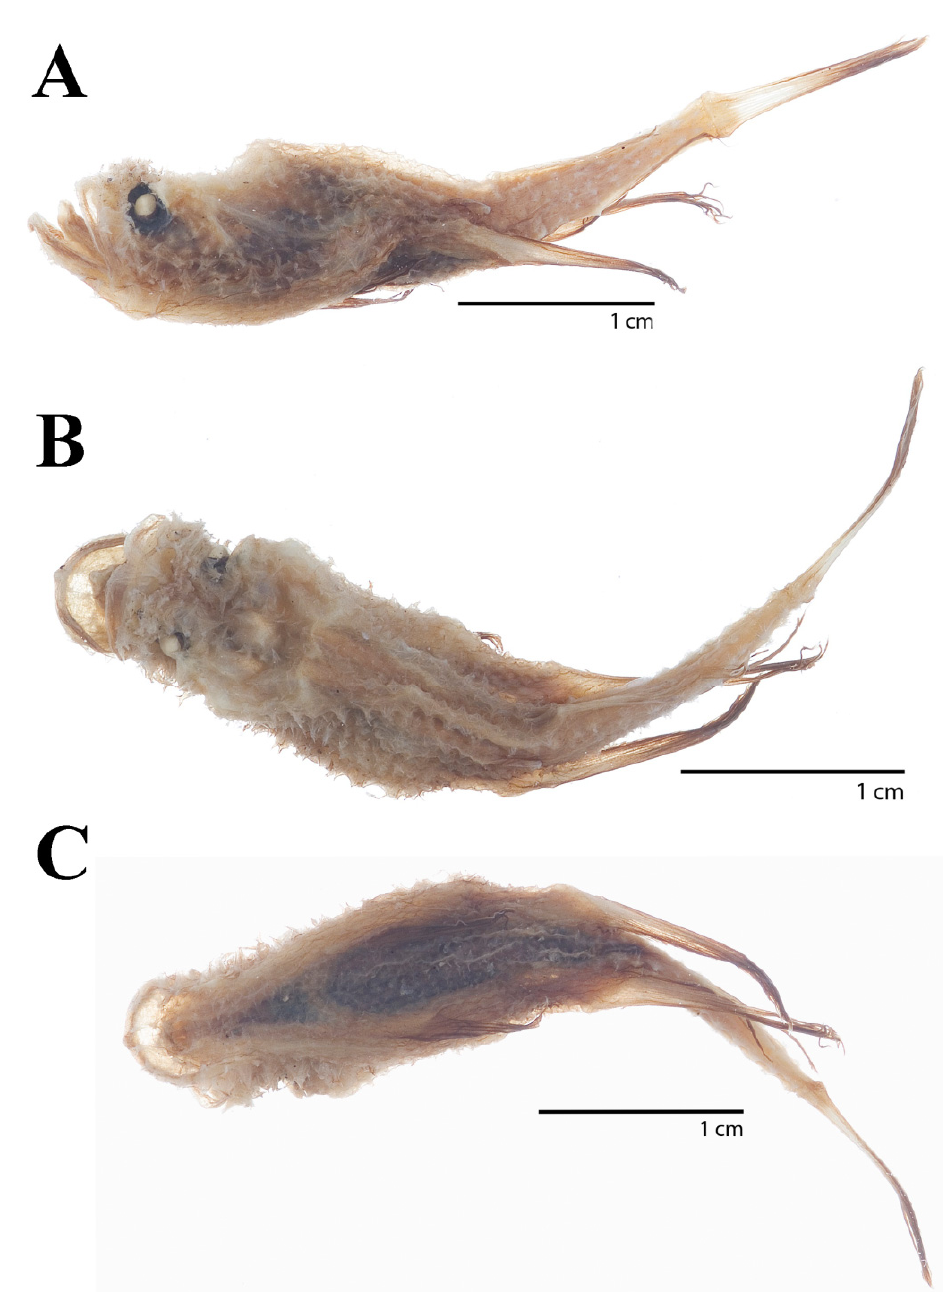
Figure 25. Halieutopsis oblonga (Smith and Radcliffe, 1912), holotype, USNM 144223, 47.5 mm SL (once dried out). ( A ). Lateral view. ( B ). Dorsal view. ( C ). Ventral view. Photos by S. Raredon, courtesy of USNM.